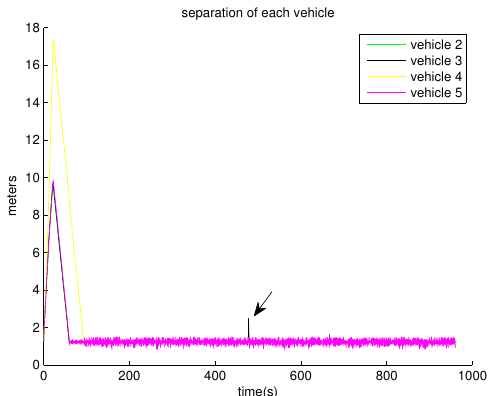
Figure 5. This figure shows the separation between every neighboring truck. γ = 1.01 is used. The separation converges to the desired separation as time goes on. An overshoot (marked with arrow) happens at the moment when the truck changes its lane. See Figure 3 for the moment when the truck changes its lane.